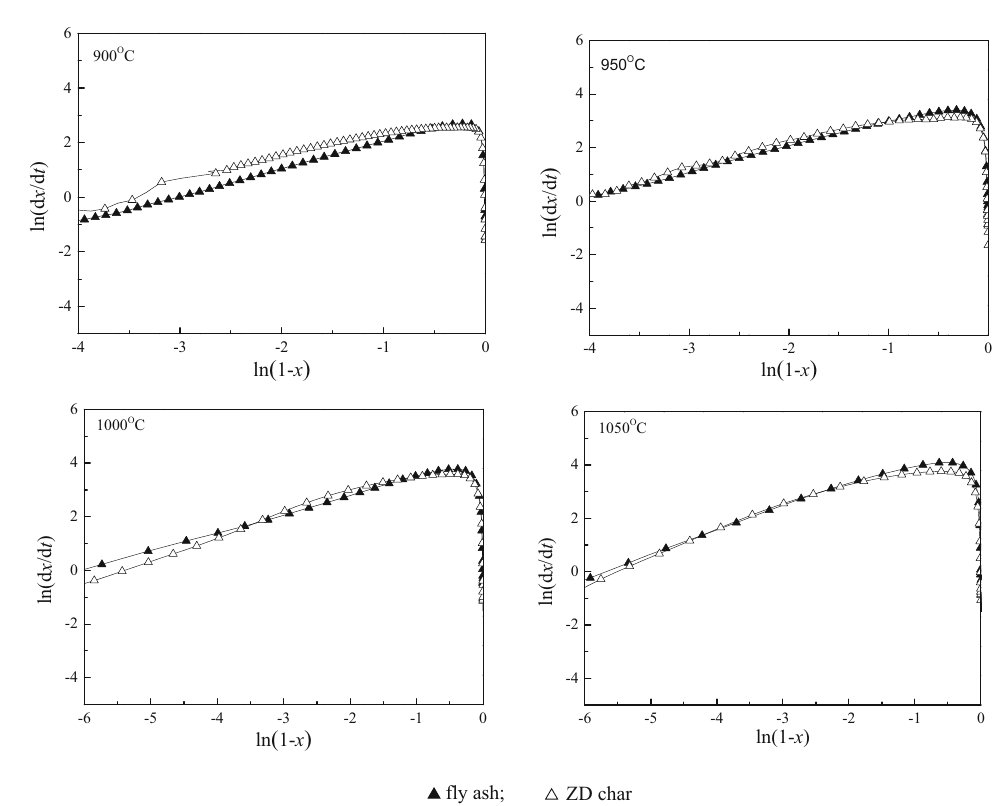
Fig. 9 ln (dx/dt) versus ln (1 - x ) curve fitted by integrated model. Filled triangle: fly ash; open triangle: ZD char Table 6 Kinetics parameters for fly ash and ZD char Samples Temperature ( (cid:3)